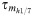
Modelling the effects of inter-cellular variability in transcription, translation and degradation rates and delays.1A: Her1/7 feedback loop in which Her1/7 protein inhibits expression of her1/7 genes. There is a delay in transcription of τmh1/7 and a delay in translation of τph1/7. Stimulation is given by → and inhibition by ⊣. 1B-1H: The oscillating Her1 population levels for five independent cells in the system (blue, red, green, magenta and cyan) and overlaid mean population level of all 100 cells in the system (black) versus time for variability in reaction rate, delay and number of Hes6 molecules. The mean population levels reflect how synchronous the oscillations of neighbouring cells are in addition to the amplitude of oscillation of the individual cells. Inter-cellular variability is distributed as a Gaussian distribution with mean, μ, and standard deviation, σ, i.e. as N(μ, σ
2). The mean value is given by the fitted values for each parameter (see S2 Text) with the maximum variation possible before qualitative changes in oscillatory behaviour occur. Quantification methods for desynchronisation can be found in Methods and S3 Fig. 1B: Variability in transcription rate, α
h, distributed as α
h ∼ N(33,92). The system is very robust to changes in transcription rate. Cells are still oscillating in synchrony after 30 oscillations. 1C: Variability in translation rate, β
h, distributed as β
h ∼ N(9.2, 1.52). The system undergoes severe damping when translation rate falls below 4.6 min-1. Cells are still oscillating in synchrony after 30 oscillations. 1D: Variability in degradation rate, λ
h, distributed as λ
h ∼ N(0.23, 0.0252). The system undergoes severe damping when degradation rate falls below 0.15 min-1. Cell clocks desynchronise in 20–21 oscillations. 1E: Variability in transcription delay, τmh1/7, for both her1 and her7, distributed as τmh1/7∼N(7,0.52). Damping of oscillation on individual cells occurs for values below 5 min. Cell clocks desynchronise in 11–12 oscillations. 1F: Variability in translation delay, τph1 and τph7 for her1 and her7 respectively, distributed as τph1∼N(1.1,0.32) and τph7∼N(0.7,0.22). Cell clocks desynchronise in 20–21 oscillations. 1G: Variability in transcription delay, τmh1/7, for both her1 and her7, distributed as Generalised Pareto distributions with parameters, location of 5.84, scale of 1.10 and shape of 0.05, resulting in expected values 7 and variances 1.5. In this instance a small number of cells have much increased transcription delay, resulting in the increased variance for the sample. Cell clocks desynchronise in 14–15 oscillations. 1H: Variability in cellular numbers of Hes6 molecules, p
h6, distributed as p
h6 ∼ N(100, 252). Cells are still oscillating in synchrony after 33 oscillations. Inter-cellular variability in the reaction rate and delay constants and number of Hes6 molecules is not of the right magnitude to explain the desynchronisation of oscillation in Notch mutants.